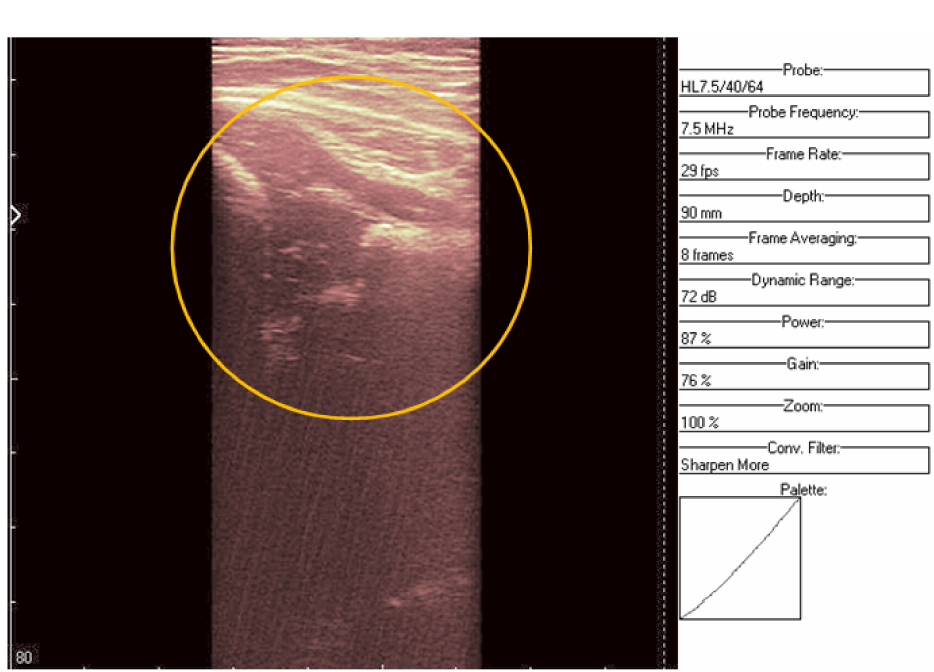
Figure 8. Original data, Image 2, with added color palette and area of interest